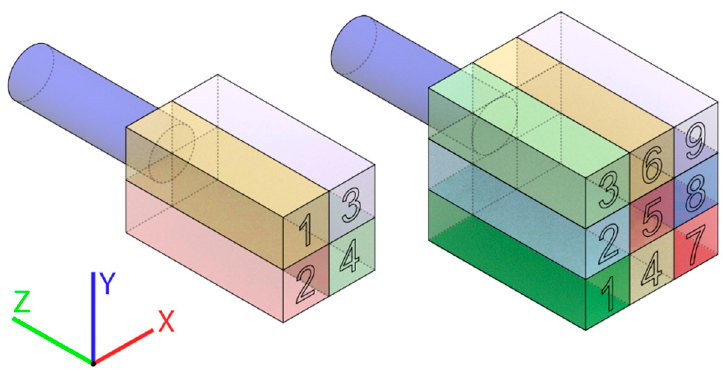
Figure 2. Schematic of the BPM power monitor layout for each splitter model with numbered monitors.